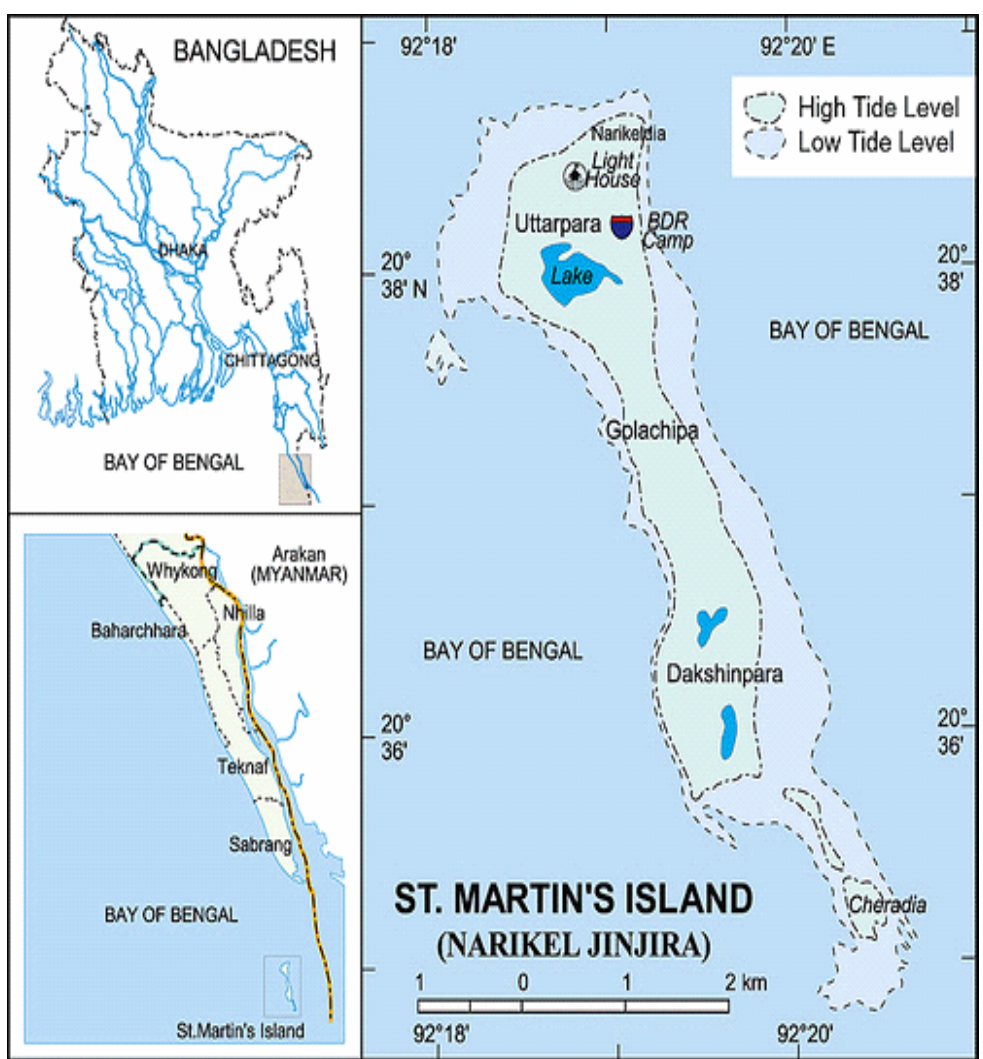
Figure 2. Map of St. Martin’s Island